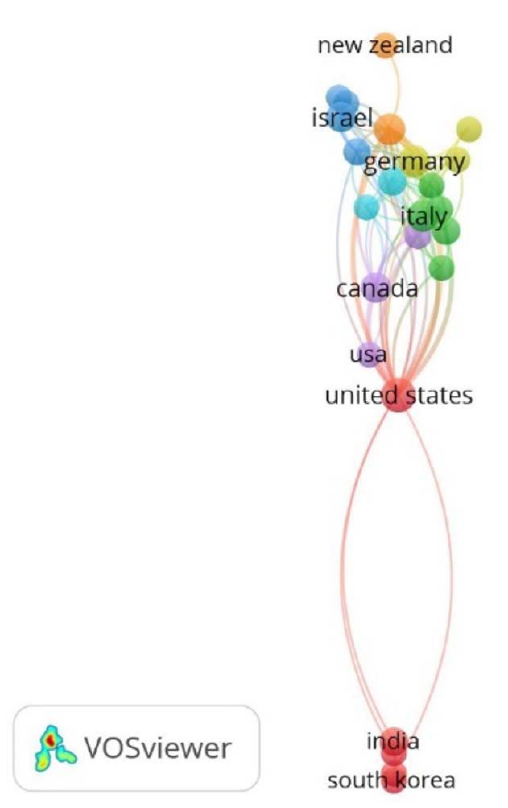
Fig. 4. The co-authorship network for countries.